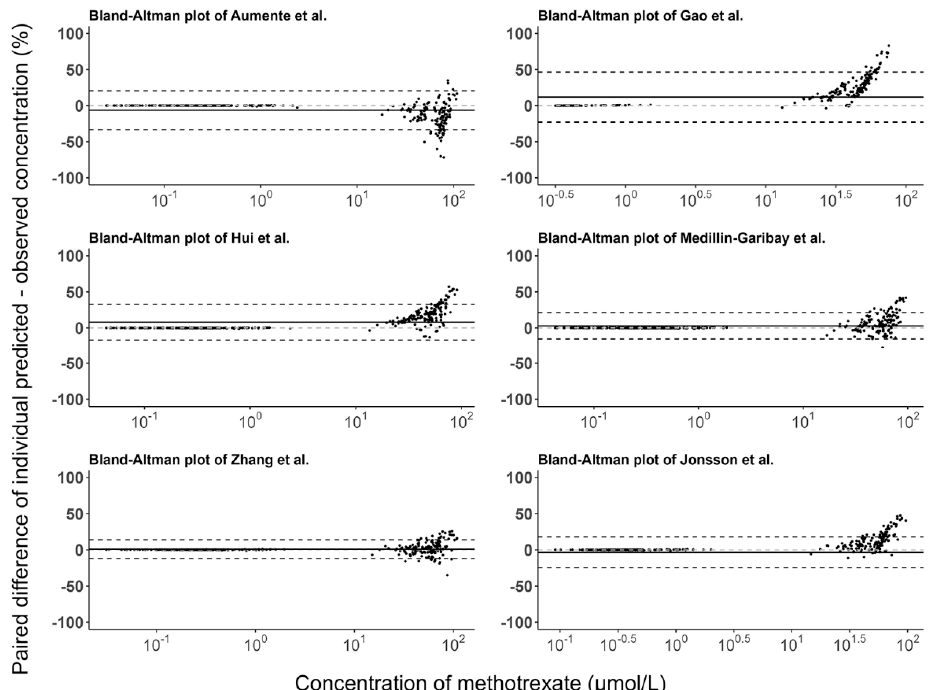
error [11,19–21,26,36].